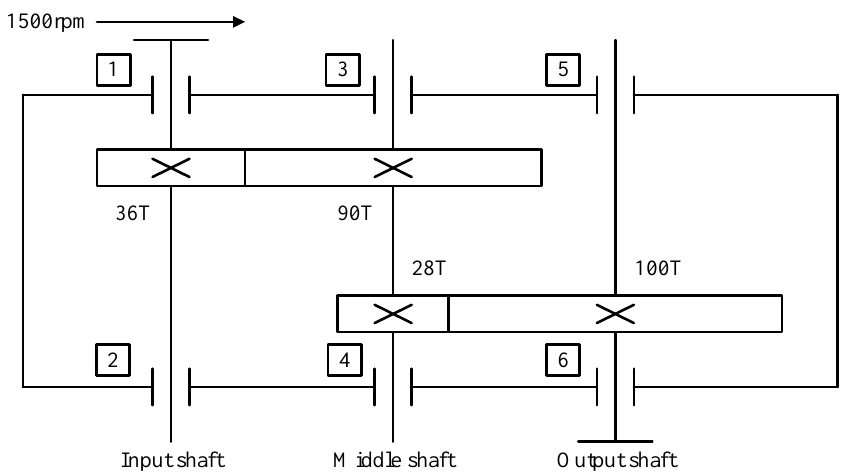
Figure 9. Structure diagram of parallel shaft gearbox.